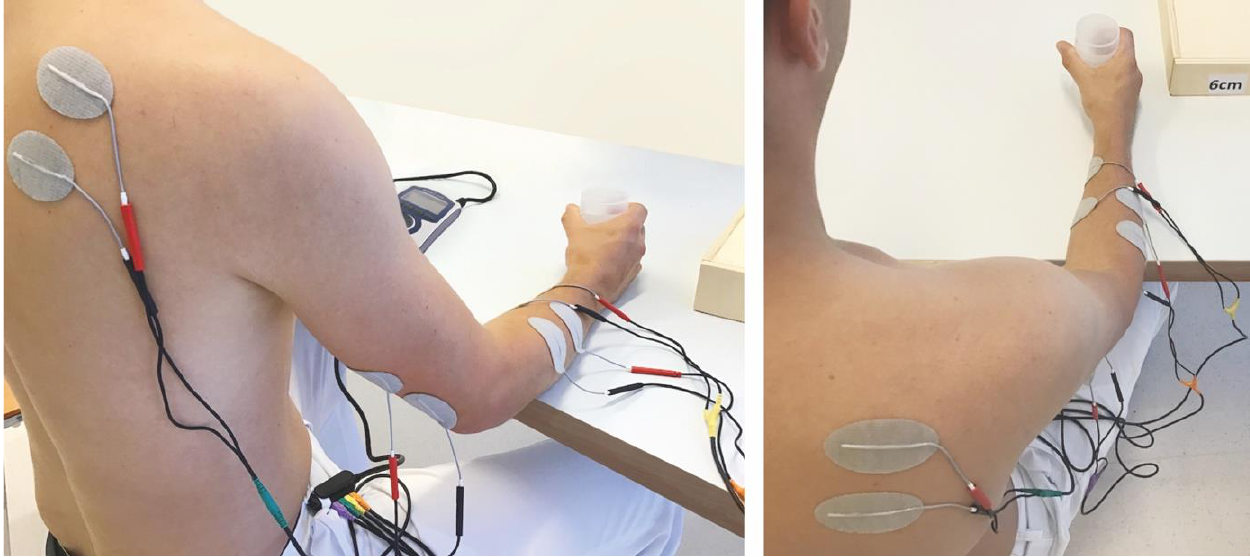
Figure 1. Model demonstrating electrode placement for the 4-channel EMG-triggered pulses for reaching, gripping, and lateral lifting of cylindrical objects to different heights.